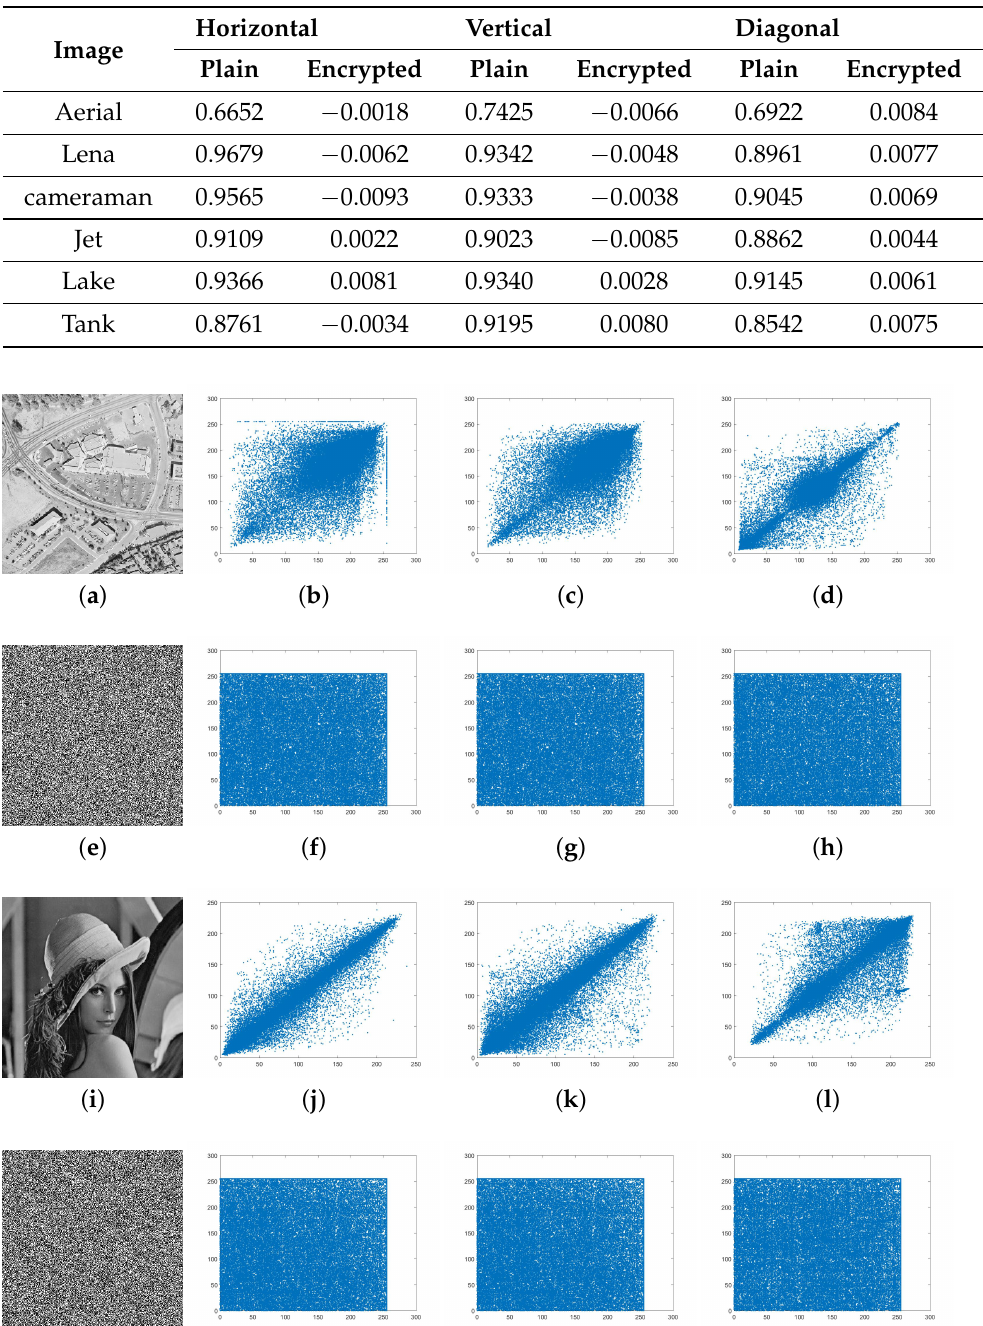
Table 3. Correlation of adjacent pixels in plain and encrypted images.